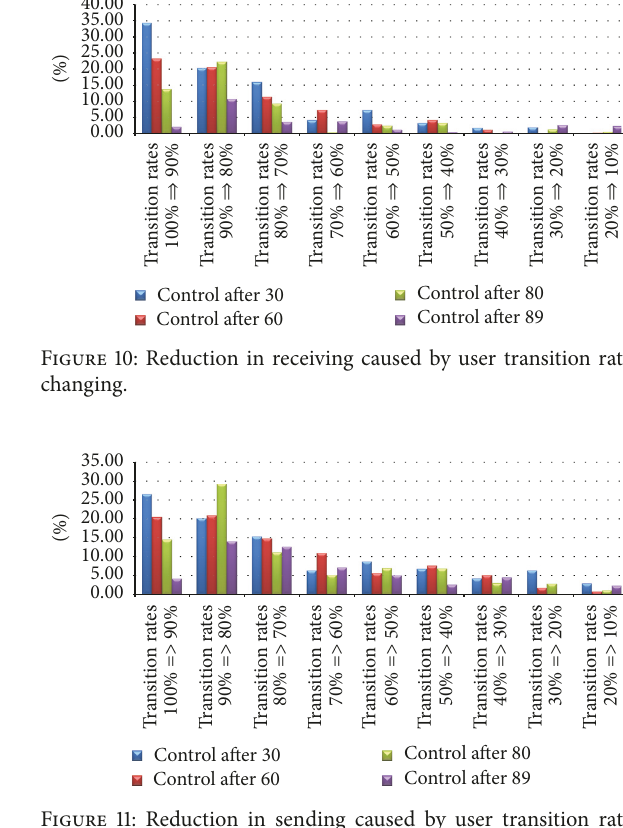
Figure 11: Reduction in sending caused by user transition rates